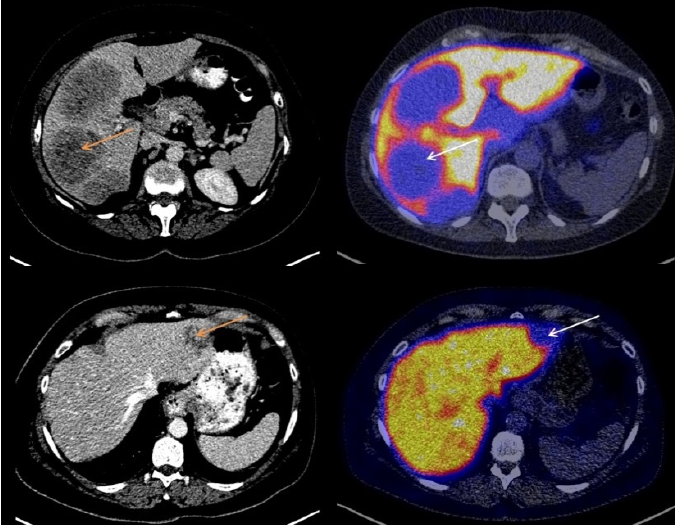
Figure 2. Two cases of low [ 18 F]-FES uptake at the site of an ER+ liver metastasis.